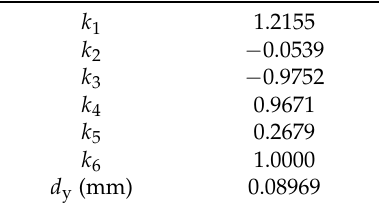
Table 6. Values of k i and d y parameters used for data processing of SCS (identification considering no strain-hardening).